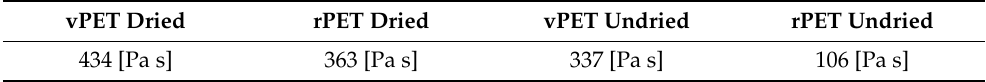
Figure 9. Complex viscosity curves for dried and undried rPET and vPET at 280 °C. Table 5. Starting complex viscosity during the oscillation